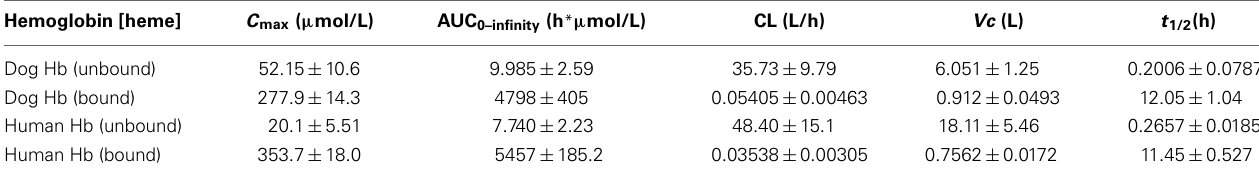
Table 2 | Pharmacokinetic parameters of dog and human Hb ( + ) prednisone (mean ± SEM) in Beagles. Hemoglobin [heme]